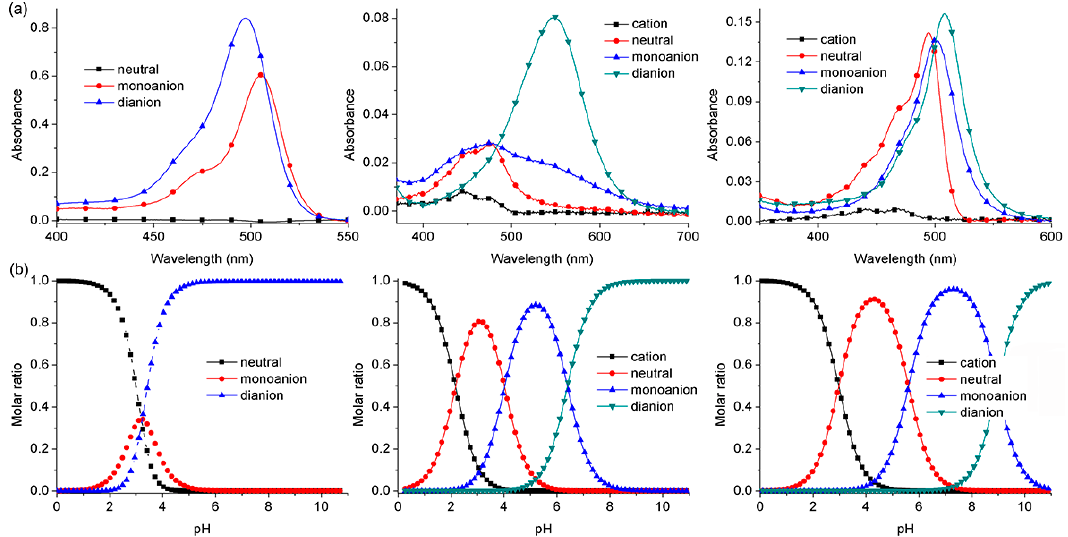
Figure 2. Selected absorption spectra of ( a ) BDNF (12.5 μ M) in EtOH:10 mM phosphate buffer (1:1, v / v ), ( b ) BDAF (2.5 μ M), and ( c ) BBDMAF (2.5 μ M) in 10 mM phosphate buffer at several pH levels at 25 °C. The spectra at pH 0.15 ‒ 1.45 were obtained in HCl solution. All samples contain 0.05% DMSO to ensure solubility.